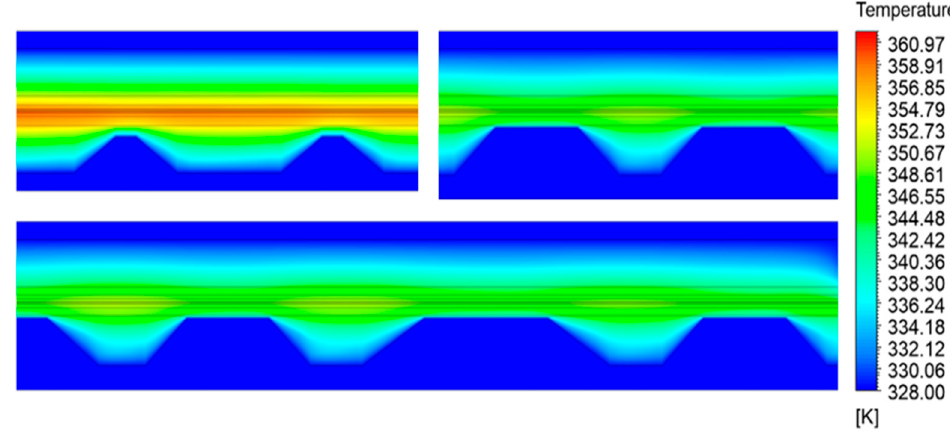
Figure 16. Temperature contours for Ref. case ( above left ), Case #45 ( above right ) and Case #45d ( below ) at current density of 4.0 A·cm − 2 .